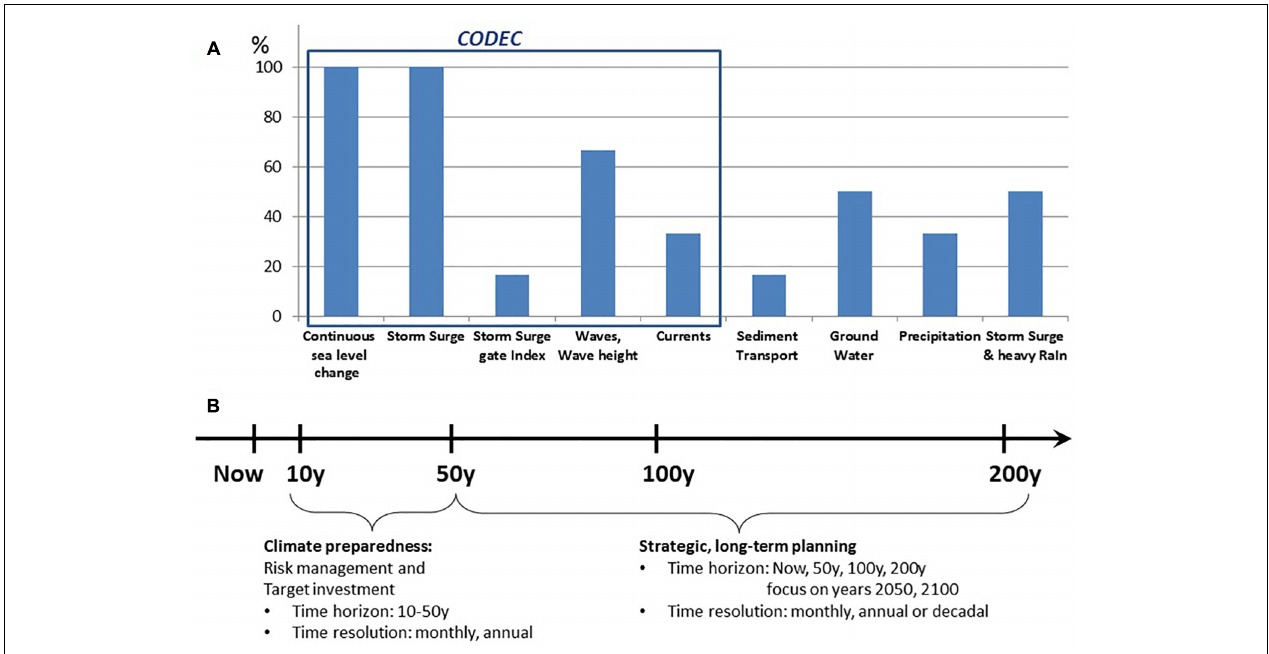
FIGURE 2 | (A) User interest in percentage of number of interviewed users. The interest areas are targeting: mean and extreme sea level for climate preparedness and planning; precipitation and coinciding storm surge and heavy rain events; as well as waves and currents for climate assessments of ocean variability and sediment transport in Køge Bay. The planned southern Copenhagen storm surge gate is in focus for one user, who has a large interest in a gate index indicating the number of high water events that will require a closing of the gates. The frame indicates topics selected to be translated into climate change indicators within the C3S_422_Lot2_Deltares CODEC contract; the selection was made based on a combination of the user requirements, the feasibility of deriving the indicators and the coastal frame of the project. (B) Illustration of the two main time scales in focus for the interviewees: user applications for climate preparedness and risk assessment (10–50 years), as well as long term strategic planning (50–200 years). The interviewed users require relatively low time resolution of the statistical products: monthly, annual or even decadal, but they require very high spatial resolution of about 1 km on regional scale (200 km × 200 km) and roughly 100 m on local, coastal